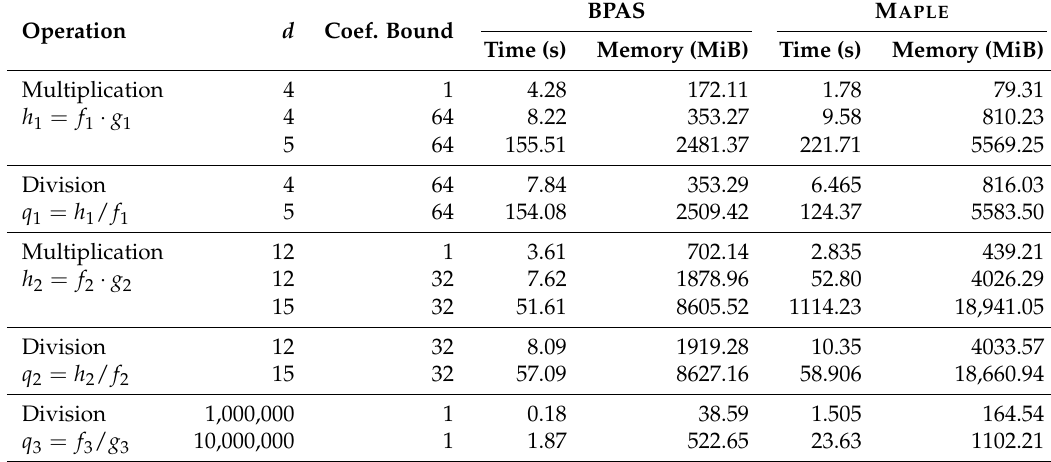
Table 1. Comparing multiplication and division on the three structured